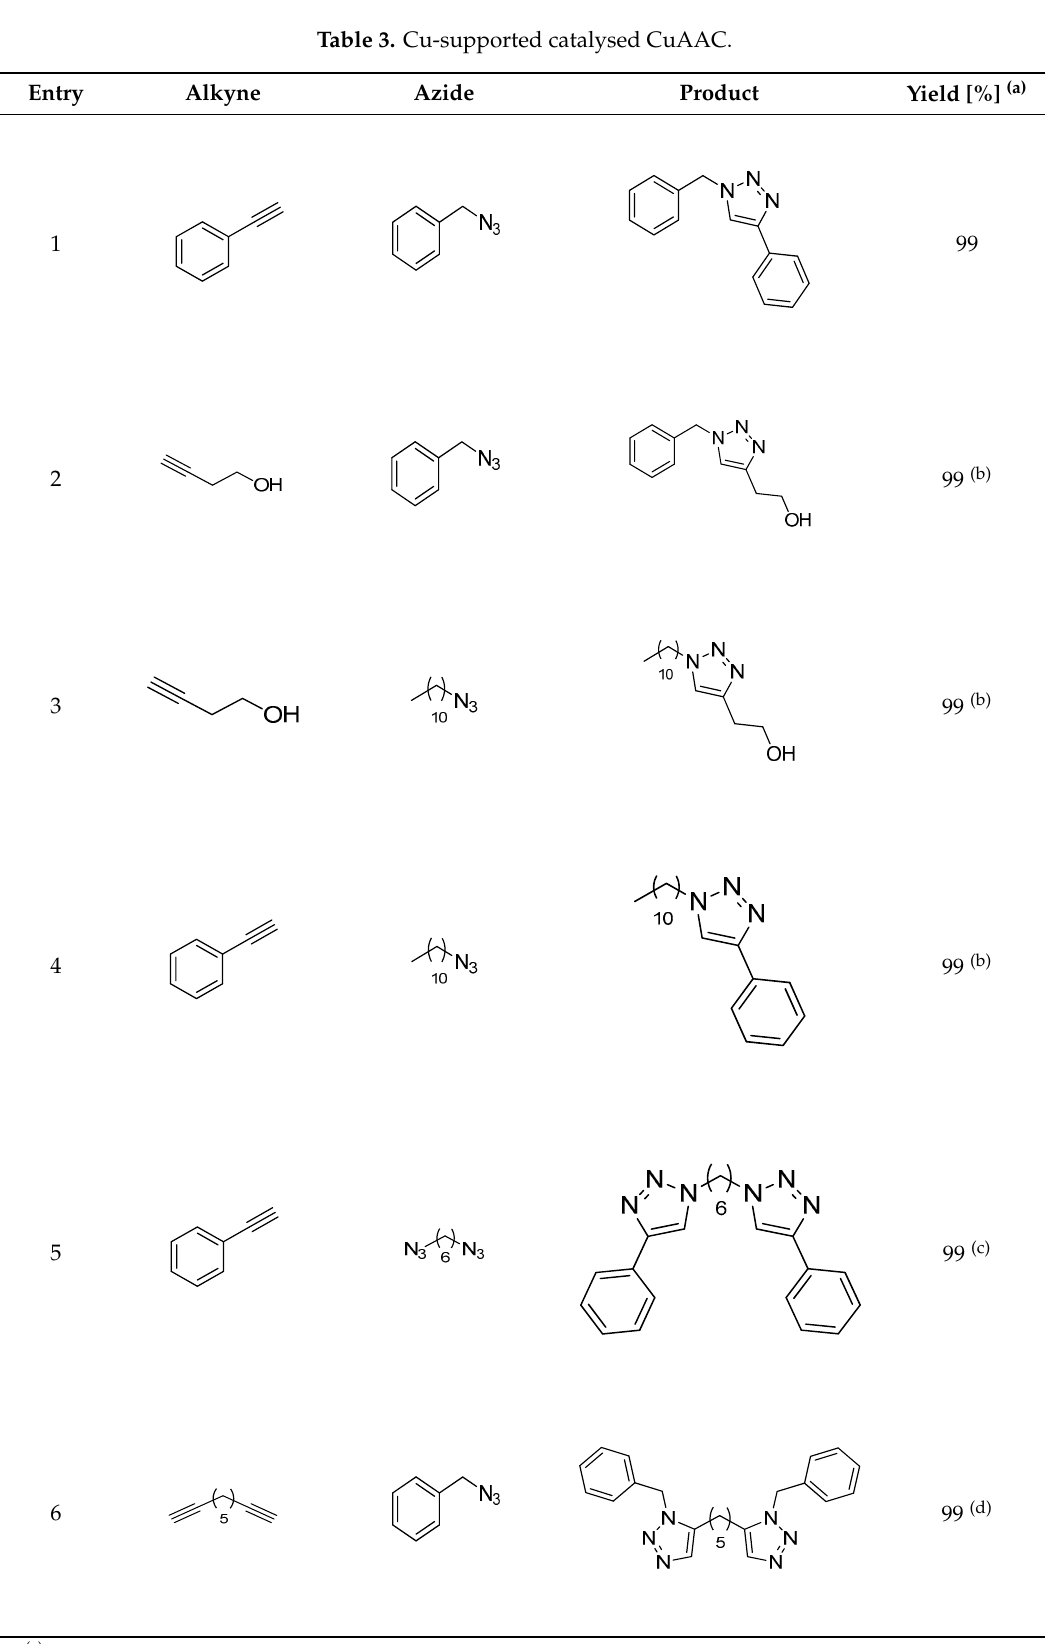
Table 3. Cu-supported catalysed CuAAC.